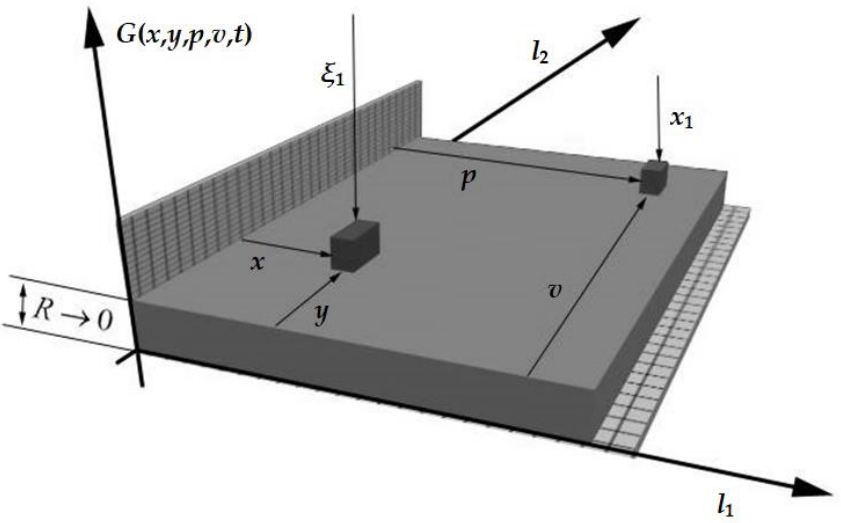
Figure 1. The object in